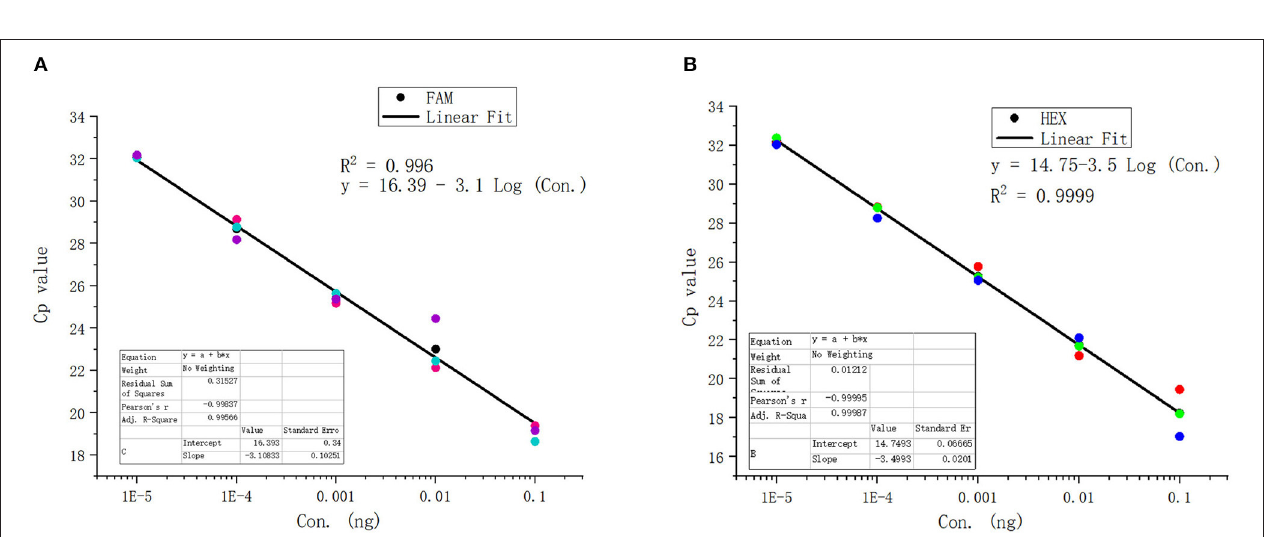
FIGURE 5 | Standard curve of the duplex real-time fluorescence quantitative PCR method. (A) results of the standard positive plasmid of B. caballi . (B) results of the standard positive plasmid of T. equi .